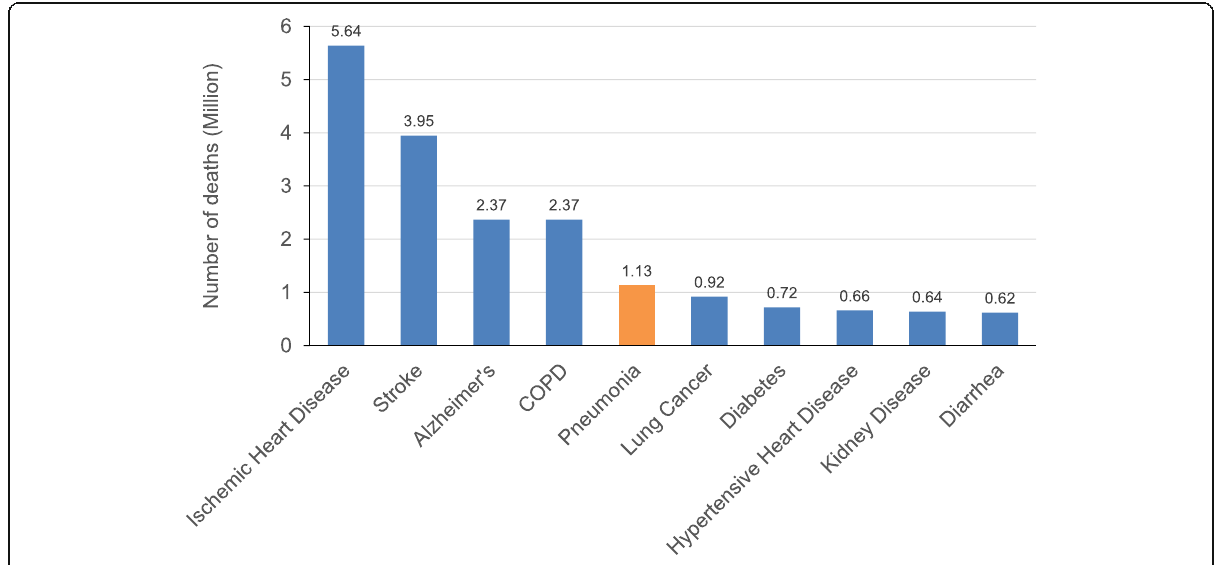
Fig. 3 Pneumonia is the fifth leading cause of death among adults over 70 (source Global Burden of Disease,